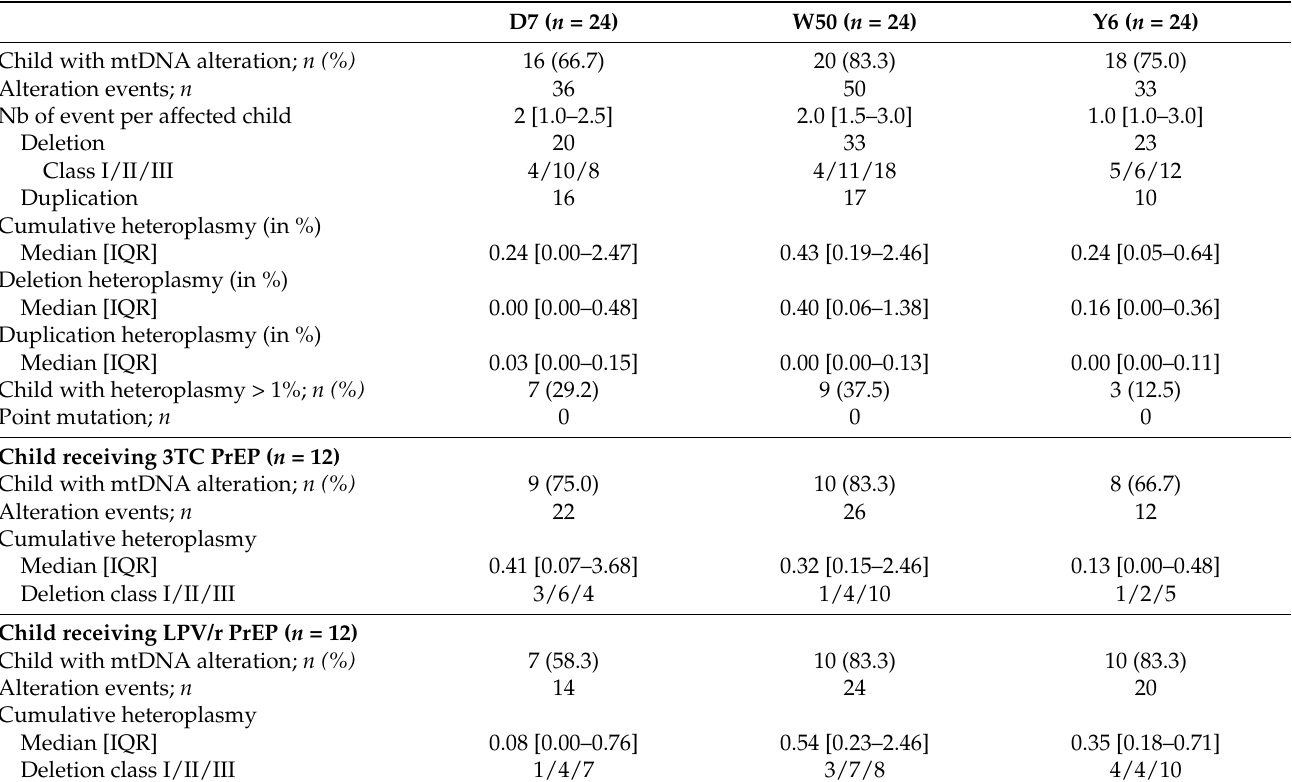
Table 3. Characteristics of HEU with mtDNA alterations from D7 to Y6.